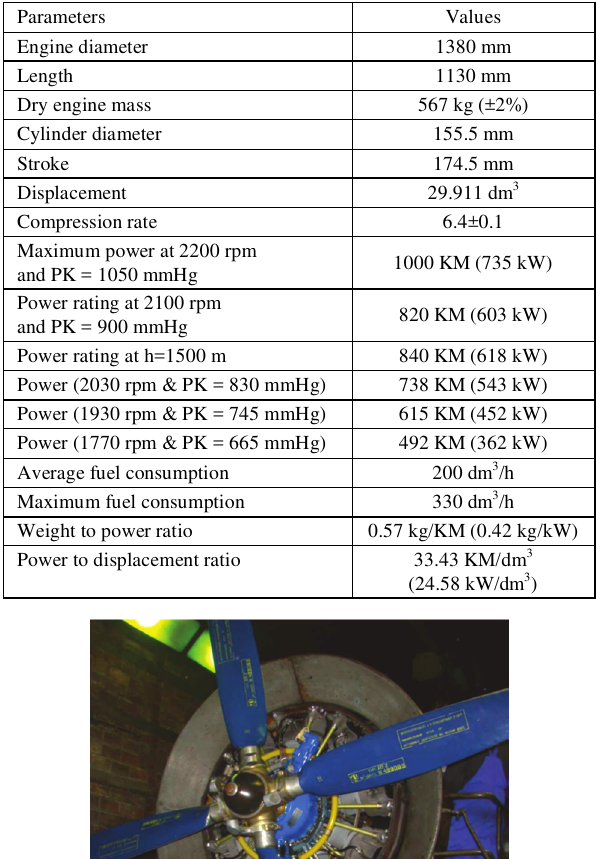
Table 1. ASz-62IR specification [2]